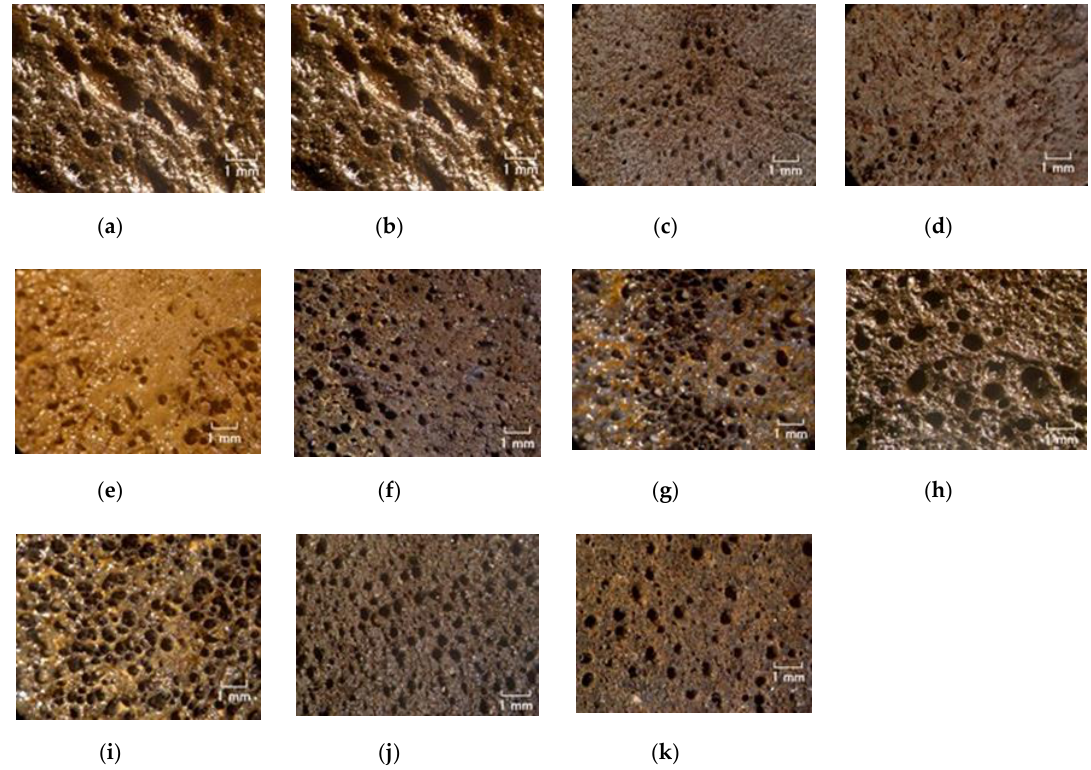
Figure 3. Photographs of surface on cathode-side electrode after electrolytic polymerization with PVA under a magnetic field; ( a ) KF96 (1000 cSt) + NR-latex (Ulacol); ( b ) KF96 (100 cSt) + NR-latex (Ulacol);